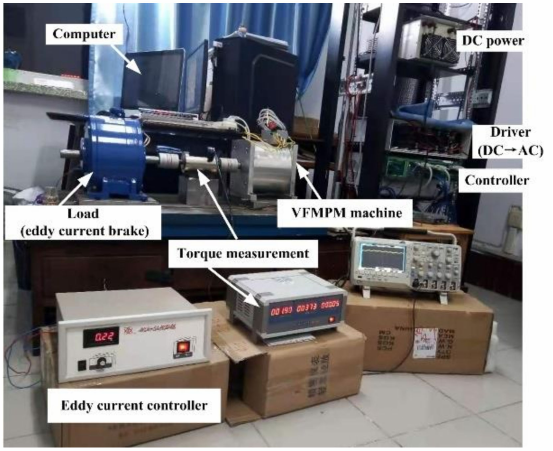
Figure 10. Test rig of cogging torque of the VFMPM machine in the load condition.